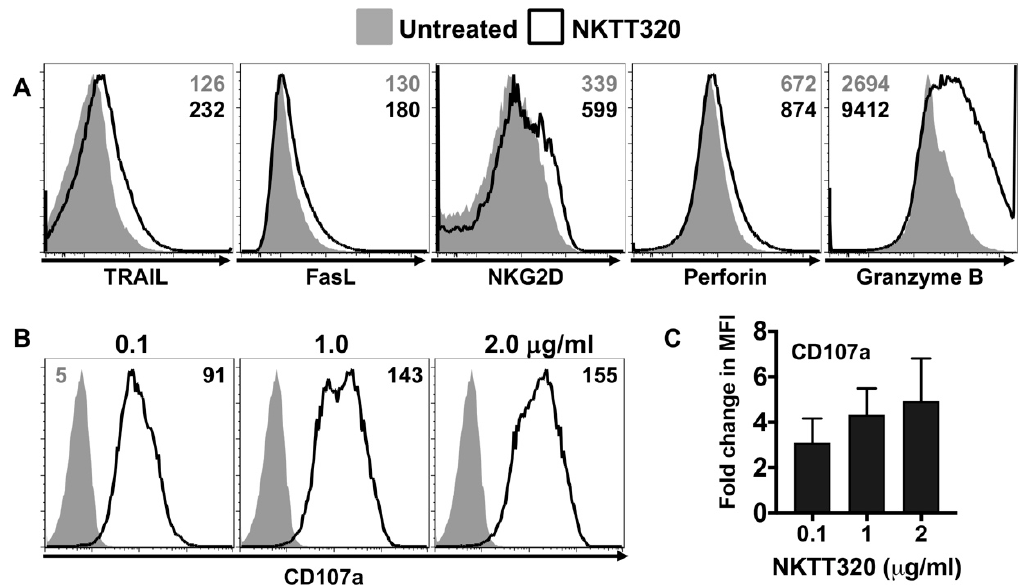
Figure 4. NKTT320 induces the upregulation of cytotoxic markers. ( A ) Freshly isolated human iNKTs were added to wells coated with plate-bound NKTT320 mAb (1.0 µ g / mL) or left untreated. After 24 h, cells were harvested and analyzed for surface expression of NKG2D, death receptors (TRAIL and FasL), or intracellular levels of lytic molecules (perforin and granzyme ( B )). ( B , C ) Human iNKTs were incubated with no stimulus or with di ff erent concentrations of plate-bound NKTT320 mAb as indicated, and analyzed for CD107a expression by flow cytometry. Data in ( A , B ) are representative of at least two independent experiments. Numbers in the histograms indicate MFI. Pooled data (mean ± SEM) from four independent experiments show fold increases in CD107a ( C ) expression on activated iNKTs, compared to those left untreated.